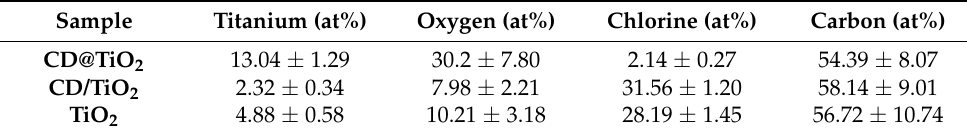
Figure 4. CD nanocomposites characterization by ( a ) XRD (CD@TiO 2 , CD/TiO 2 , and TiO 2 ); and by ( b – d ) FTIR-ATR (CD@TiO 2 ( b ), CD/TiO 2 ( c ), and TiO 2 ( d )). Table 1. EDS quantification results of the different